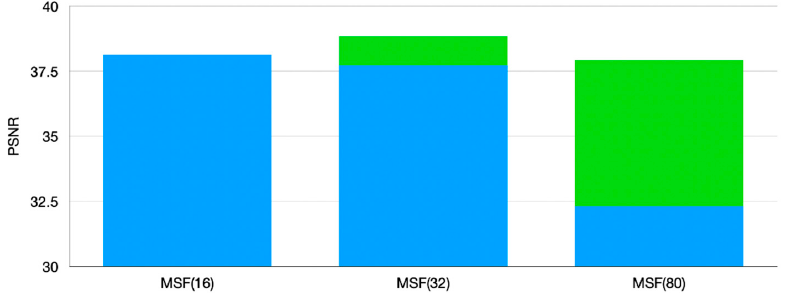
Figure 12. Comparison among MSF with different number of subordinate networks after data augmentation step; the green part is the increase obtained by data augmentation.